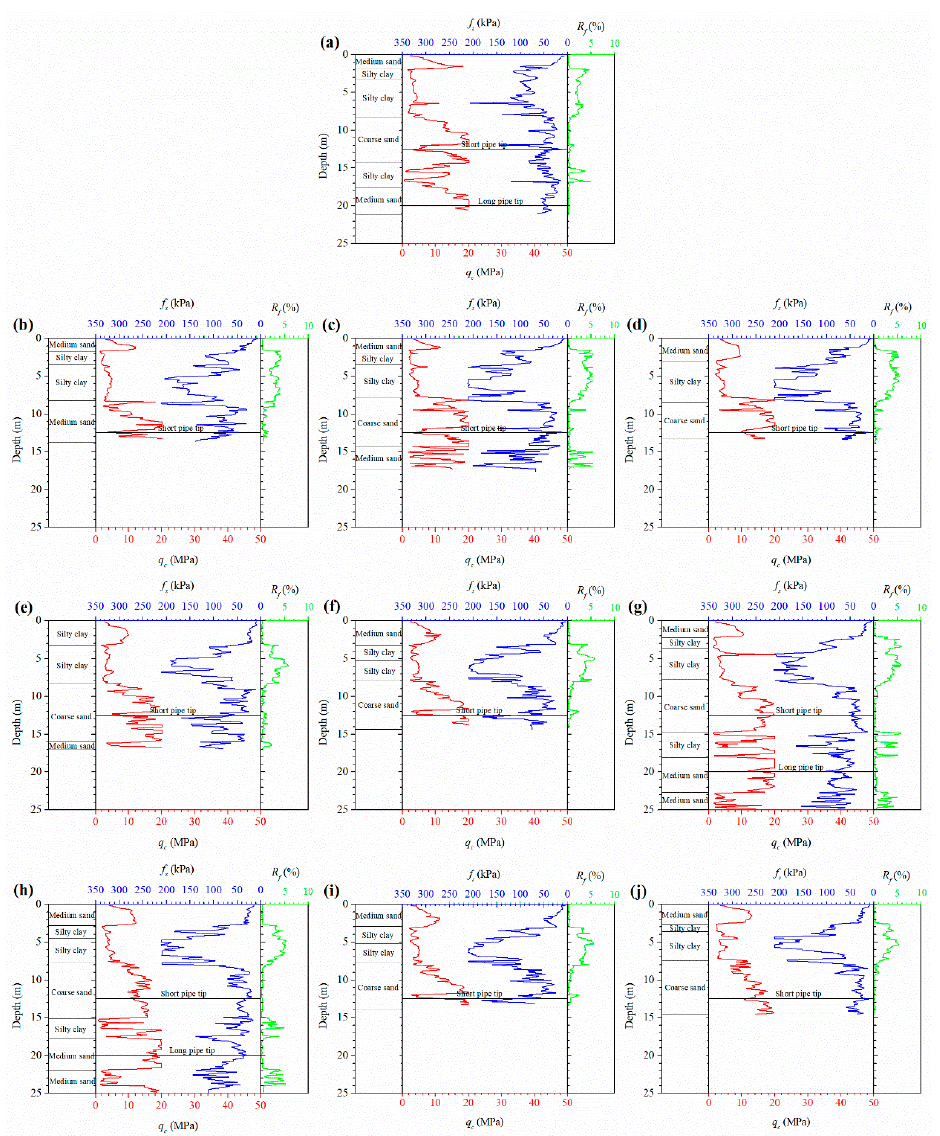
Figure 8. Cone penetration test (CPT) results ( a ) CPT-1#; ( b ) CPT-2#; ( c ) CPT-3#; ( d ) CPT-4#; ( e ) CPT-5#; ( f ) CPT-6#; ( g ) CPT-7#; ( h ) CPT-8#; ( i ) CPT-9#; ( j ) CPT-10#.